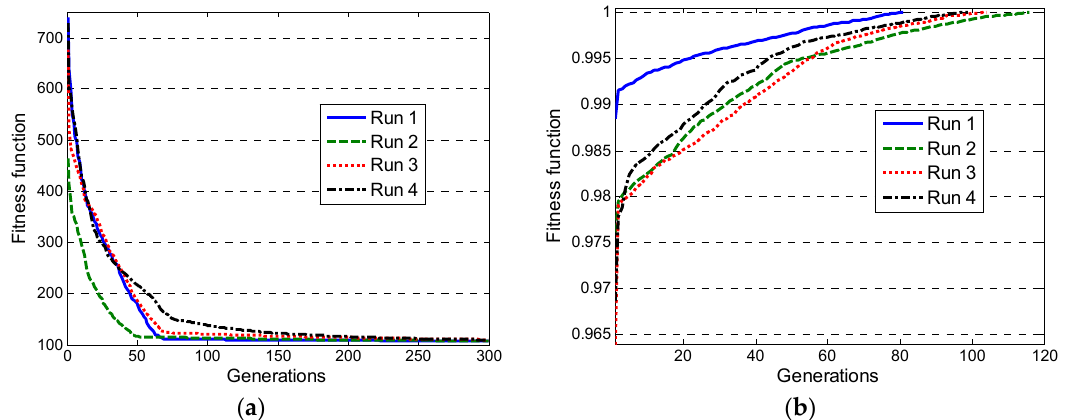
Figure 8. Convergence curves for ( a ) 𝐹 (cid:3033)(cid:2869) and ( b ) 𝐹 (cid:3033)(cid:2870) considering four independent runs (IEEE 118 bus power system).